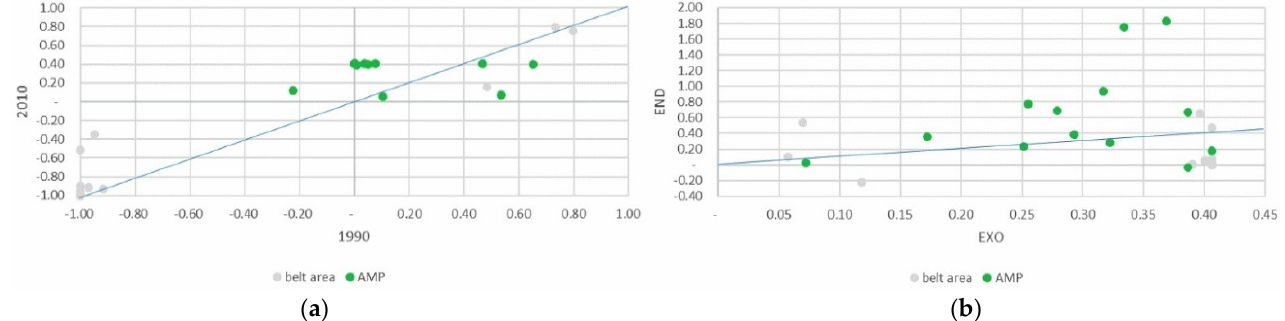
Figure 15. ( a , b ) PSI and DPSI for forage crops. Source: Drawn up by the authors using data from the ISTAT.